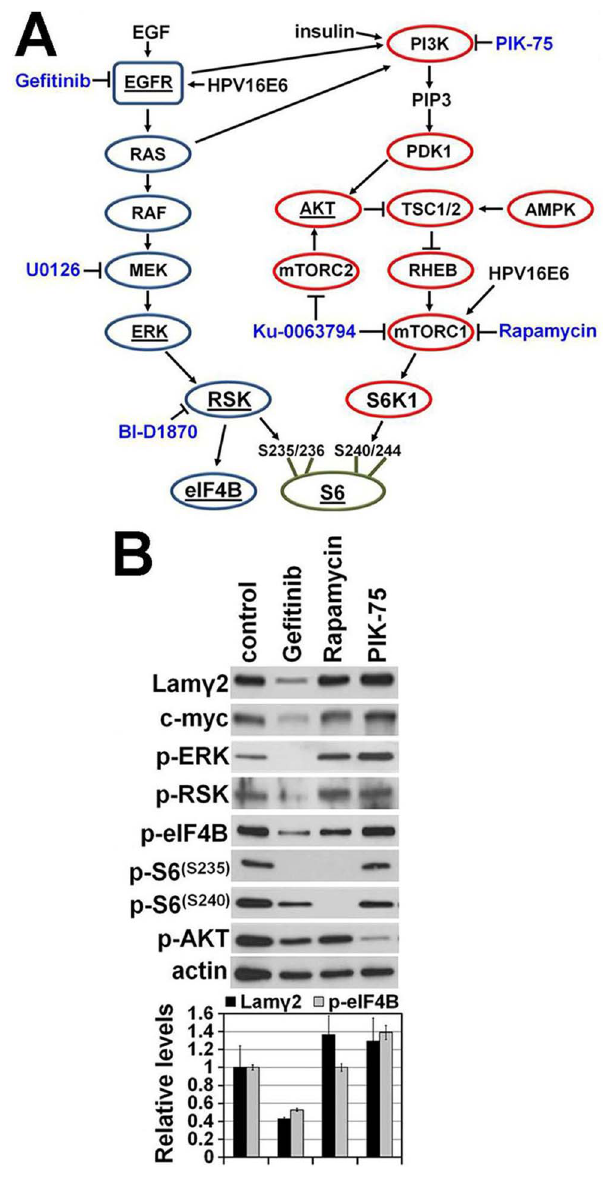
Figure 1. Effects of inhibiting MAPK vs. PI3K/mTOR pathway kinases on Lam c 2 and MYC expression. A ) Elements of the EGFR/ RAS/RAF/MEK/RSK (blue) and PI3K/AKT/mTOR (red) kinase cascade signaling pathways and their downstream targets eIF4B and S6. Arrows indicate that the upstream protein activates the downstream target, whereas lines terminating in a crossbar indicate that the upstream protein inhibits the downstream target. Kinase inhibitors are in blue font. Proteins examined for their phosphorylation states by Western blotting are underlined. B ) Western blot of confluent cultures of SCC-68 treated for 24 hr with the EGFR kinase inhibitor gefitinib, the mTORC1 inhibitor rapamycin, or the PI3 kinase p110 a -specific inhibitor PIK-75. Densitometric analysis of the Lam c 2 (black bars) and p-eIF4B (gray bars) bands of each lane is shown in the bar graph below the blot. Lam c 2 and p-eIF4B levels were normalized to the actin level in each lane and then levels of Lam c 2 and p-eIF4B in inhibitor-treated cultures were expressed relative to those in the untreated control